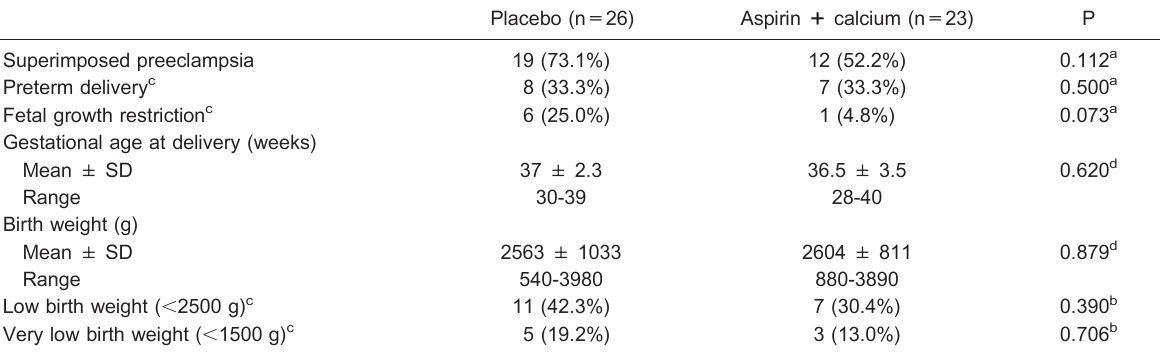
Table 2. Pregnancy outcomes of 49 women with chronic hypertension and abnormal uterine Doppler at 20-27 weeks gestation randomly assigned to receive placebo or aspirin plus calcium supplementation during